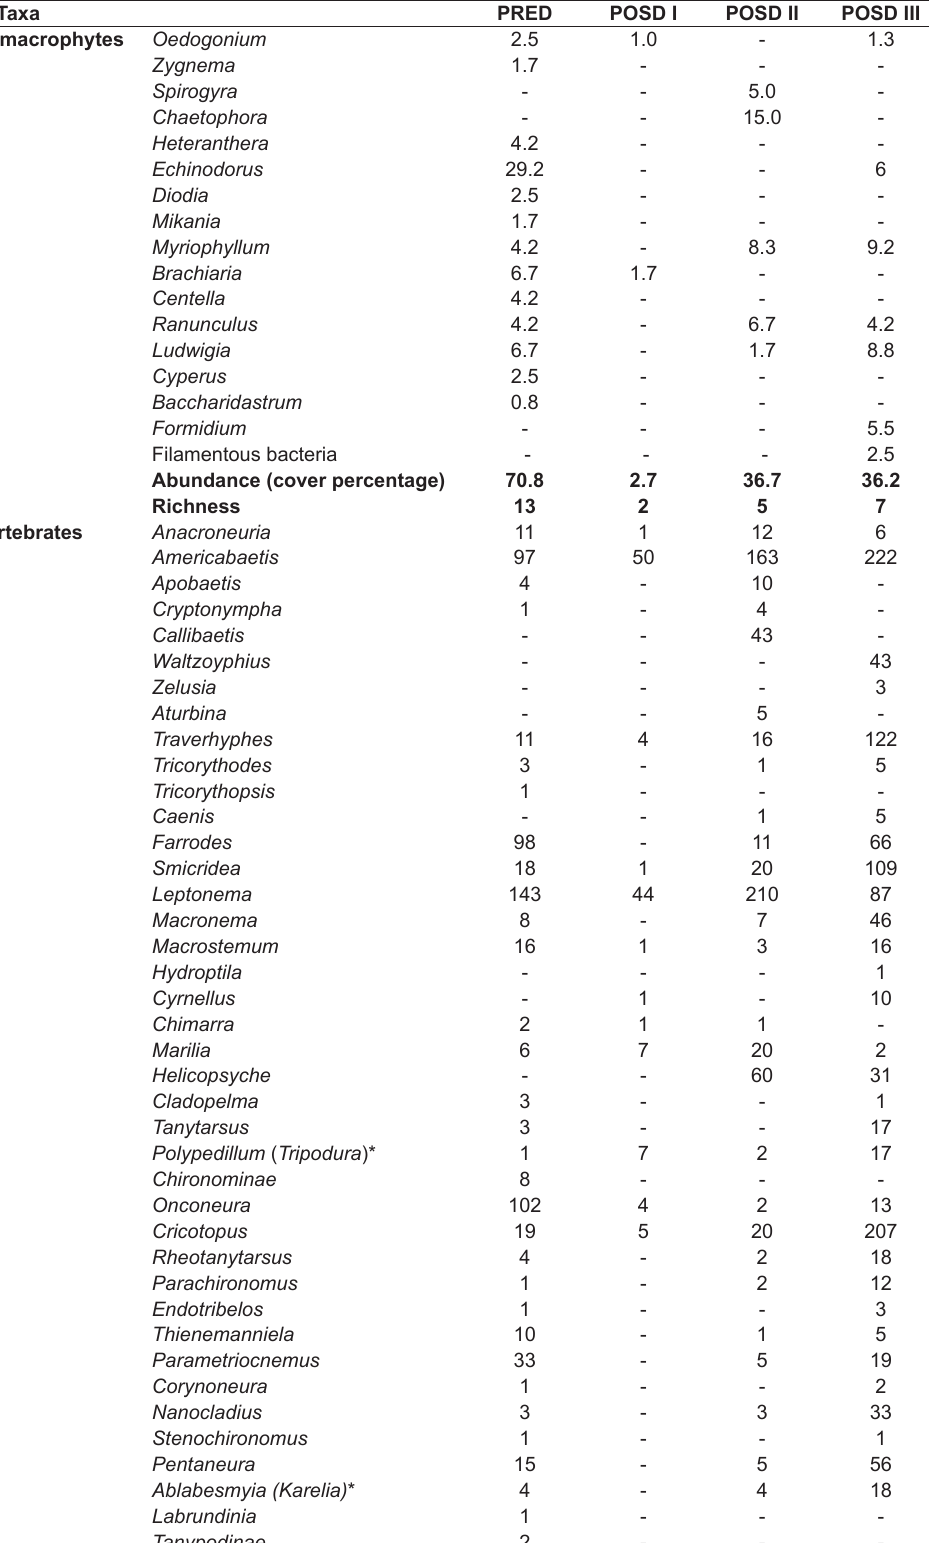
Table 3. Richness and abundance of each taxa sampled in the studied periods (pre-disturbance - PRED; post-dis- turbance I - POSD I; post-disturbance II - POSD II; and post-disturbance III - POSD III). Algae and macrophytes abundance was determined through visual estimation of hole reach coverage